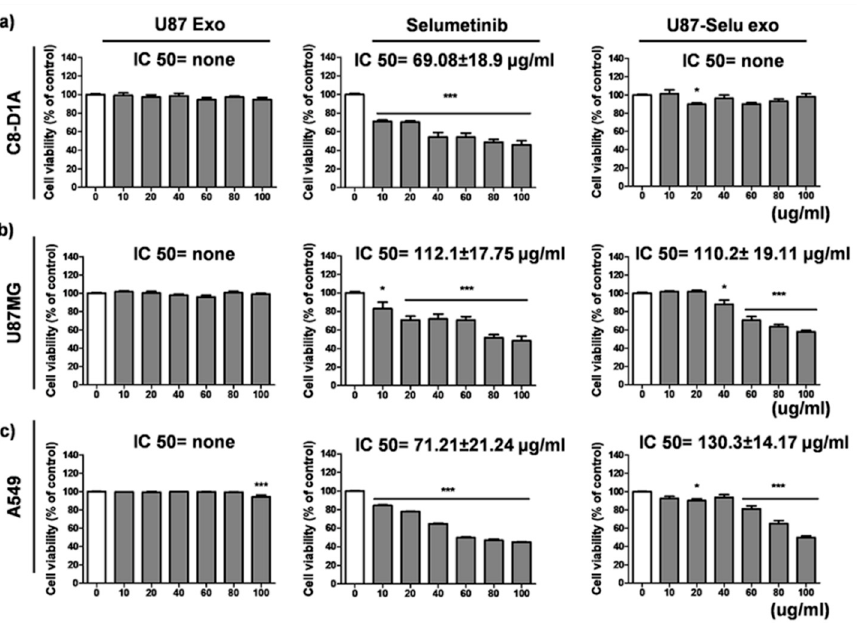
Figure 8. Cytotoxicity of U87 exo, selumetinib, and U87-Selu exo of ( a ) C8-D1A (mouse normal brain cells), ( b ) U87MG (human glioblastoma cells), and ( c ) A549 (human lung cancer cells) cells at various concentrations. * p < 0.05, *** p < 0.001 vs. non-treated viability value of each data, n = 3. Data represented as mean ± SD.